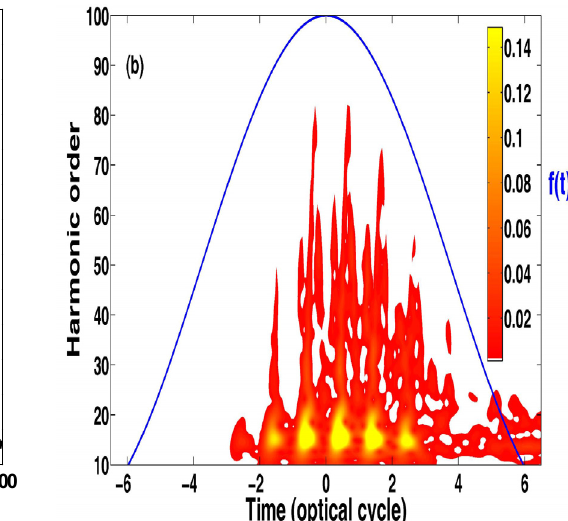
Figure 2. ( a ) Molecular high-order harmonic generation (MHOHG) spectra of HeH 2+ in linearly polarized laser fields; ( b ) wavelet analysis of the harmonic generation. The insets in ( a ) are the enlarged areas of the MHOHG spectrum. The left inset shows the harmonics in the purtabative regime without shift. The right inset presents the harmonics near the cutoff with noticable red shift. The internuclear distance R = 4 a.u. is fixed. The initial state is the ground 1 s  state. The laser polarization is along the z axis, i.e. , the orientation angle 15 3.5 10 I  W/cm 2 . The wavelength is 400 nm. The ( ) f t with a duration of 15 optical cycles as illustrated in ( b